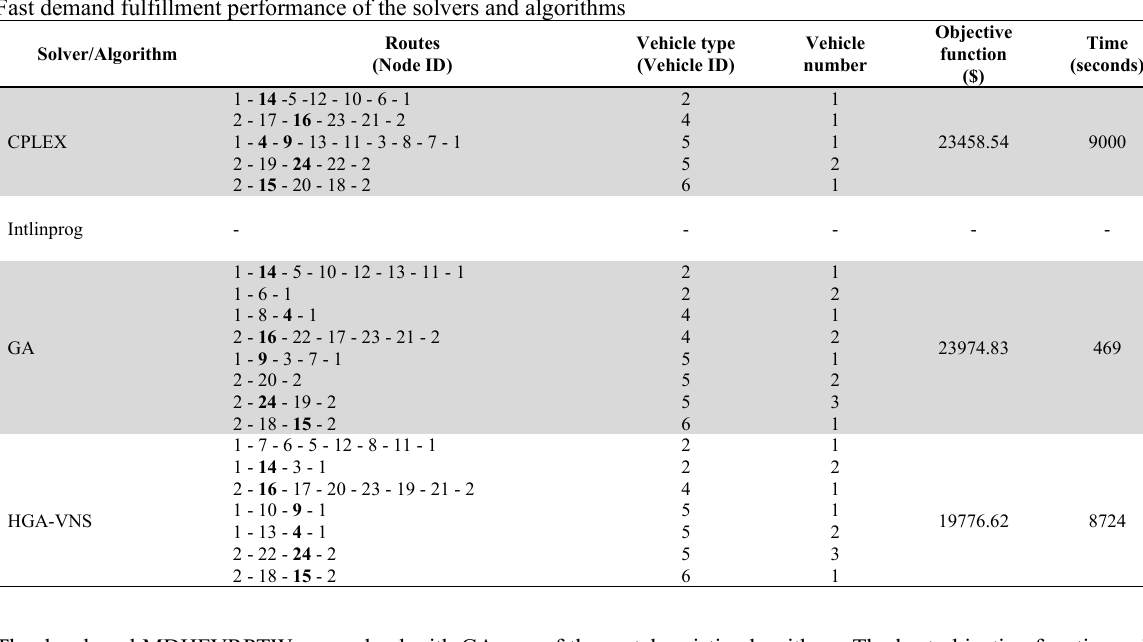
Fast demand fulfillment performance of the solvers and algorithms Solver/Algorithm